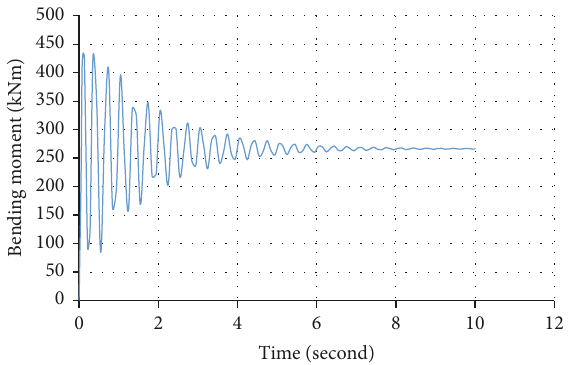
Figure 10: The bending moment of connecting beam to middle column upper node versus time in dynamic model.